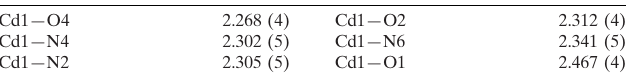
Selected bond lengths (A˚ ).